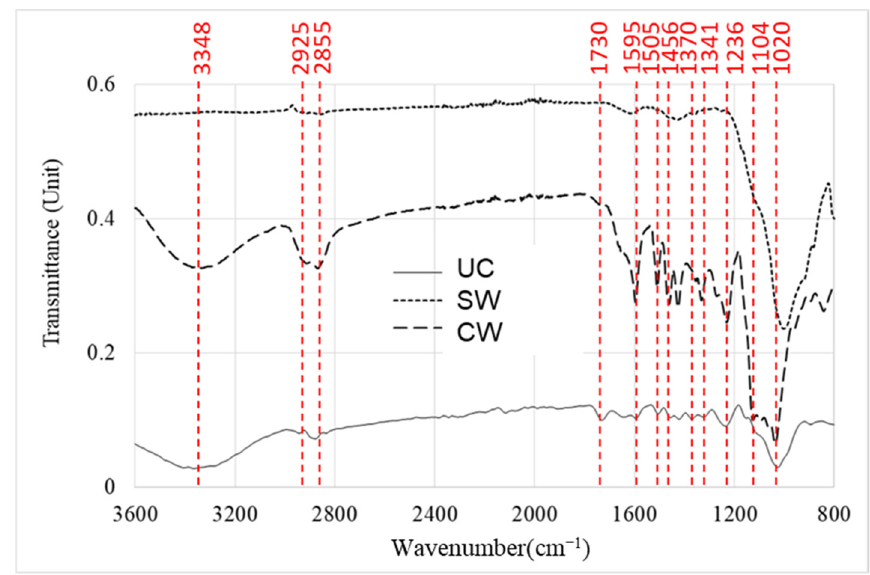
Figure 3. FTIR spectra of ancient shipwreck wood from Huaguang Jiao I.